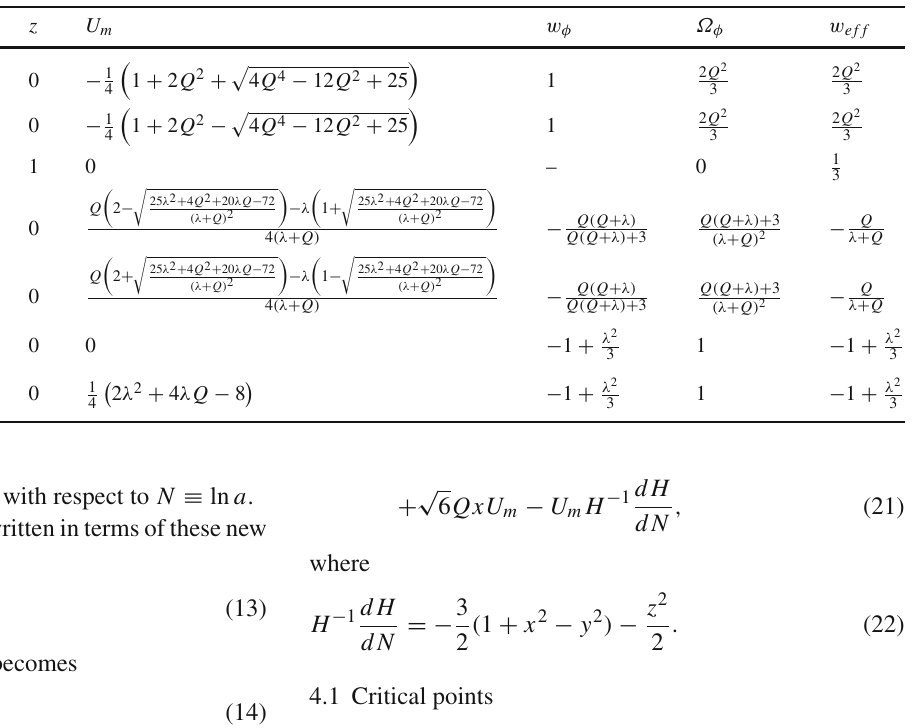
Table 1 Critical points ( x , y z , U m ) for quintessence field. U m was found only for the viable points that may describe one of the three cos- mological eras. The table shows the correspondent equation of state for